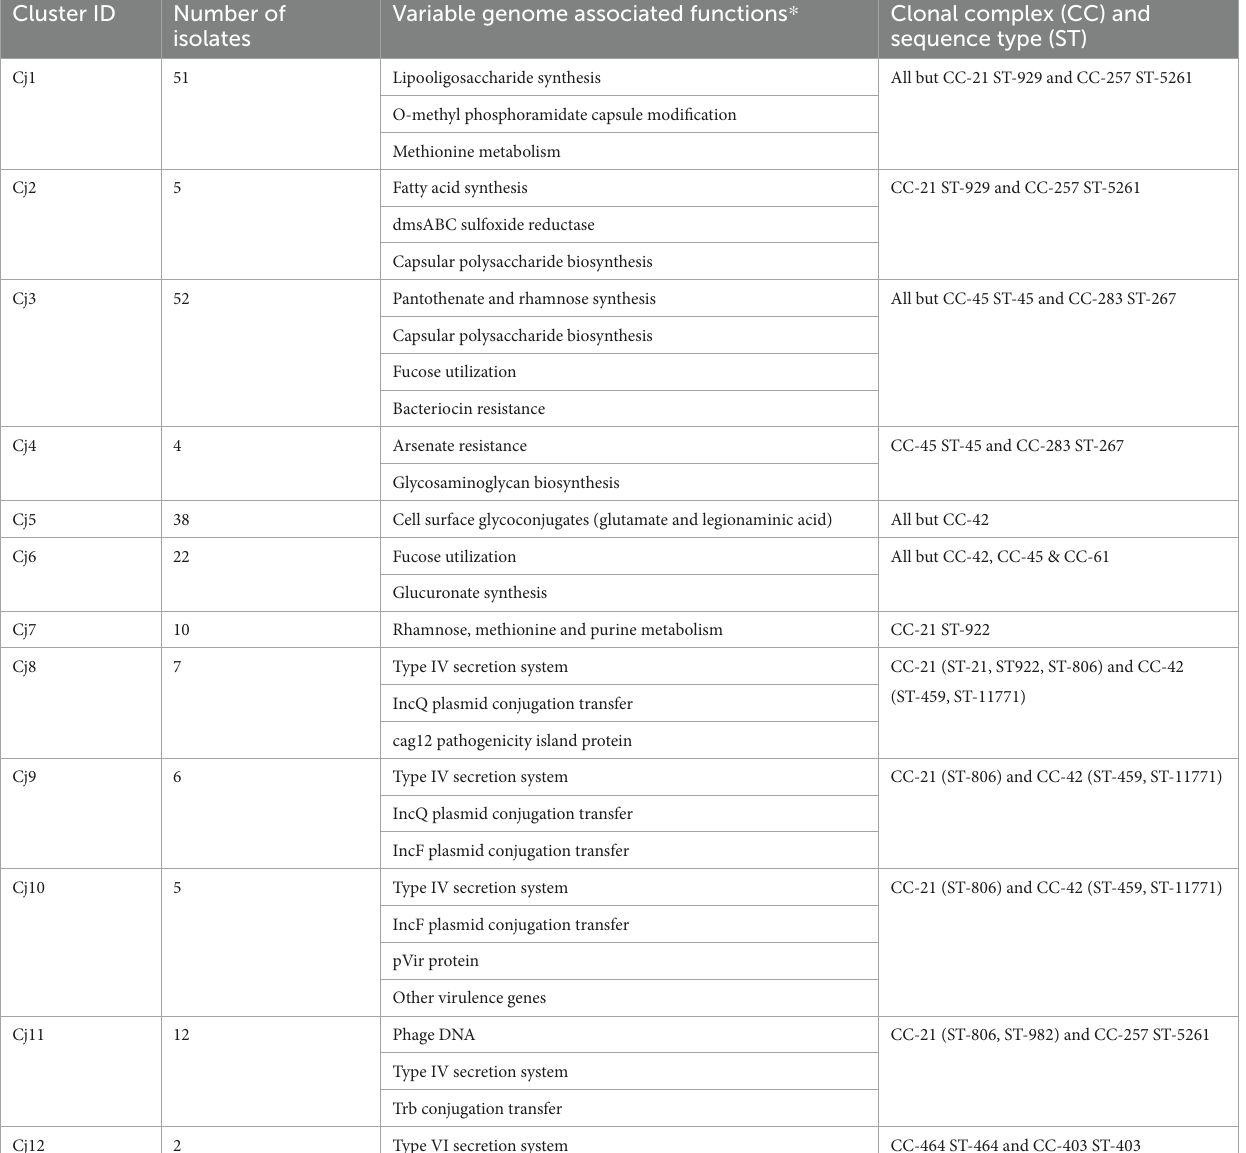
TABLE 4 Variable genome clusters in Campylobacter jejuni isolates. Cluster